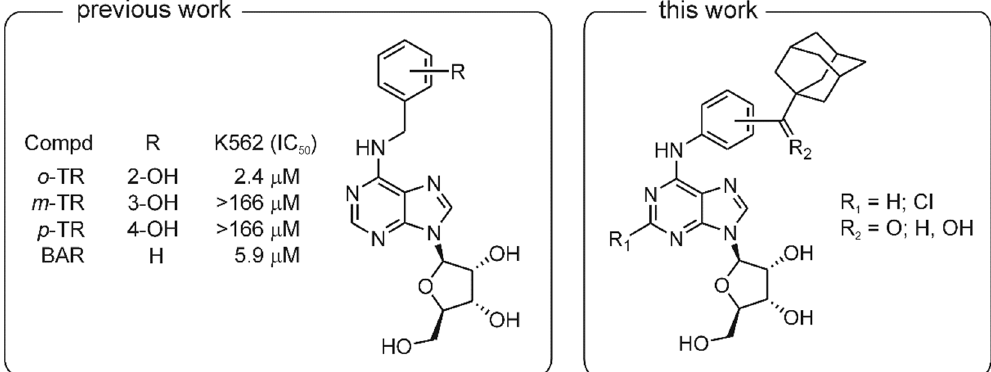
Figure 2. Purine nucleosides considered in this work and structurally related derivatives with their antiproliferative activity towards the K562 cell line. IC 50 values were taken from a previously published paper [11].